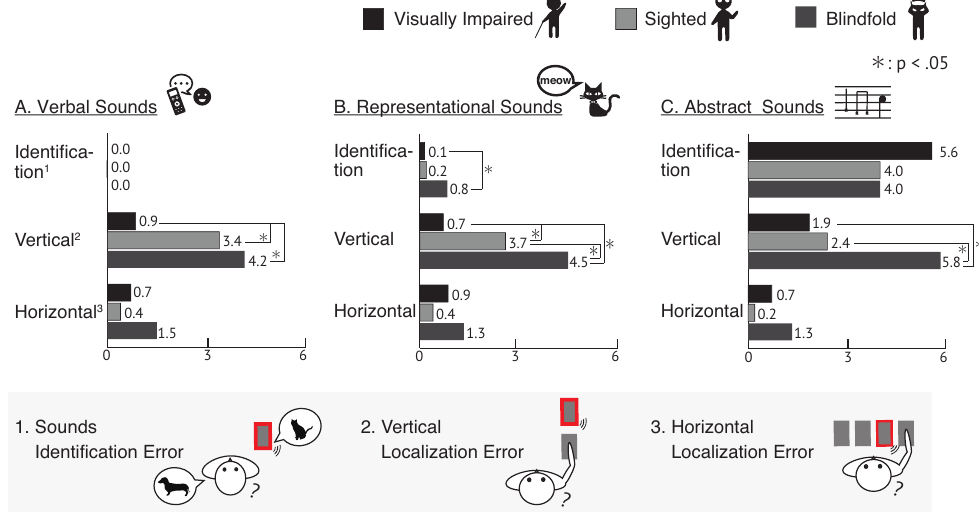
Figure 10. The average number of errors per trial for the experimental participants. There were three types of errors: sound identification errors, vertical localization errors, and horizontal localization